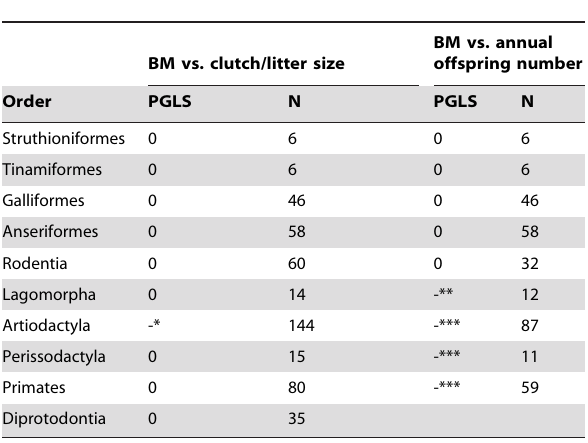
Table 2. Correlations between body mass and reproductive characteristics for different avian and mammalian